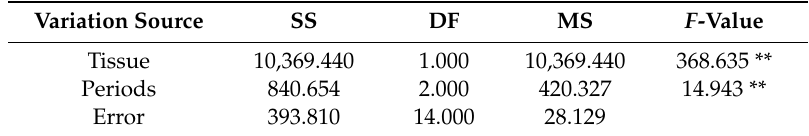
Table 3. Analysis of variance of lignin